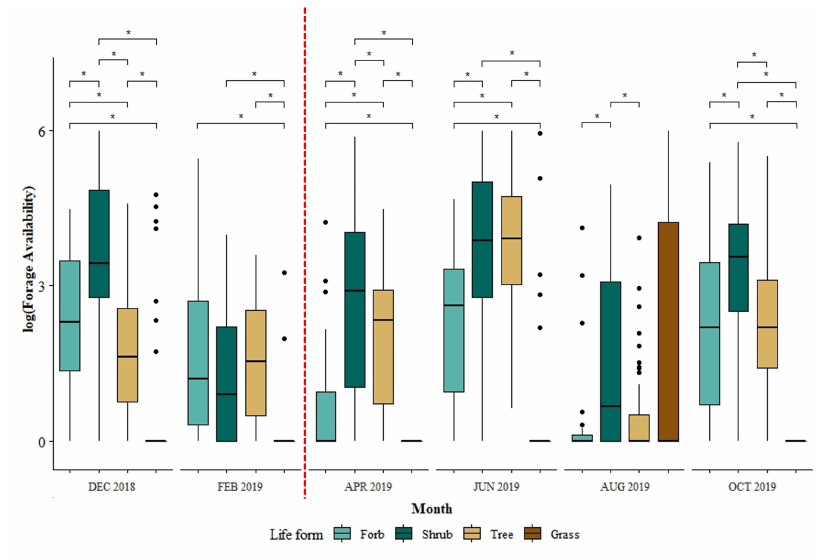
Figure 3. Forage availability for the different life forms over six sampling times. The dashed vertical red line shows the period of prescribed burning (22 February to 31 March 2019). The black dots represent data points that are beyond 1.5 times of the interquartile range (IQR) away from the mean. The asterisks (*) indicate a significant difference from the pairwise comparison with the Wilcoxon rank-sum test.